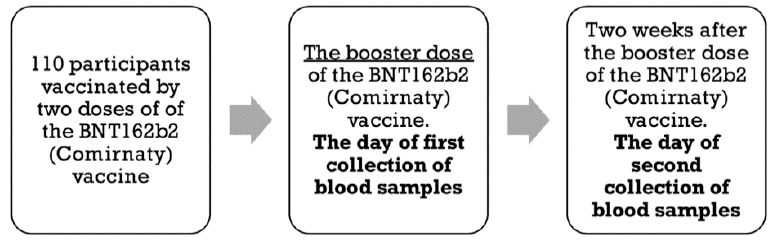
Figure 1. The scheme showing the steps of the